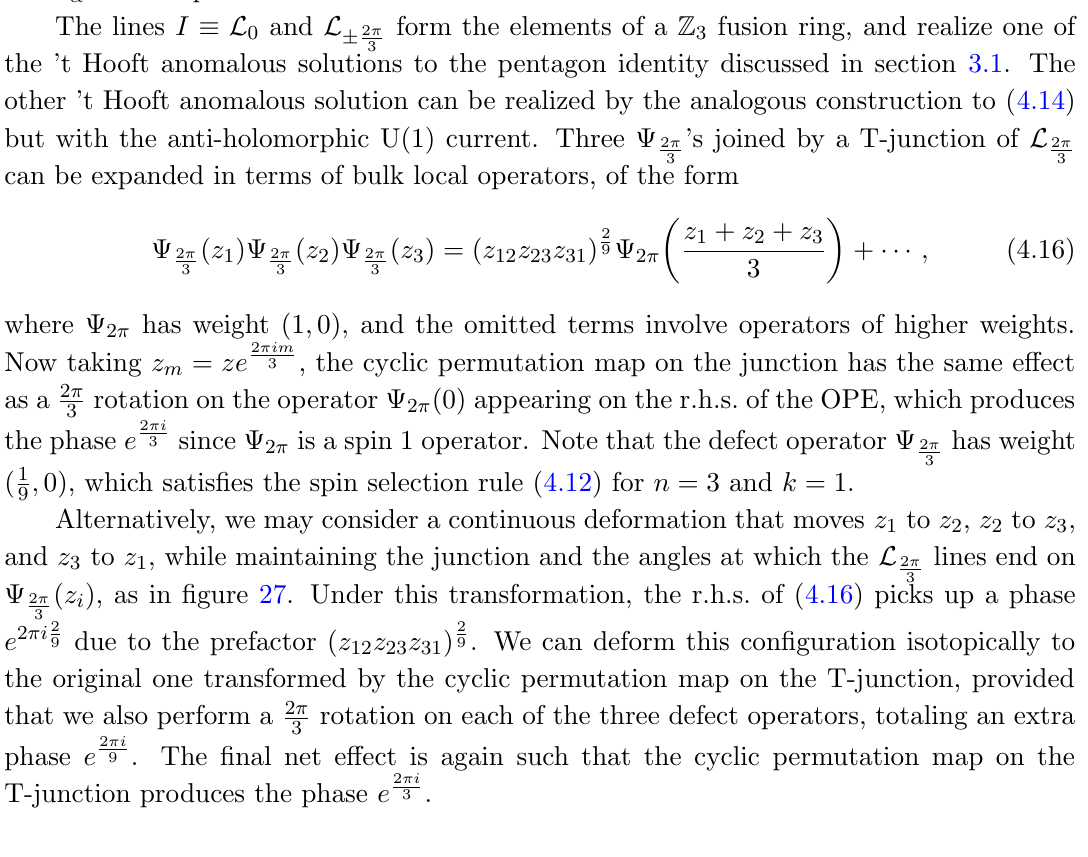
Figure 26 . Relation between the spins of states in H L order n = 3 element g